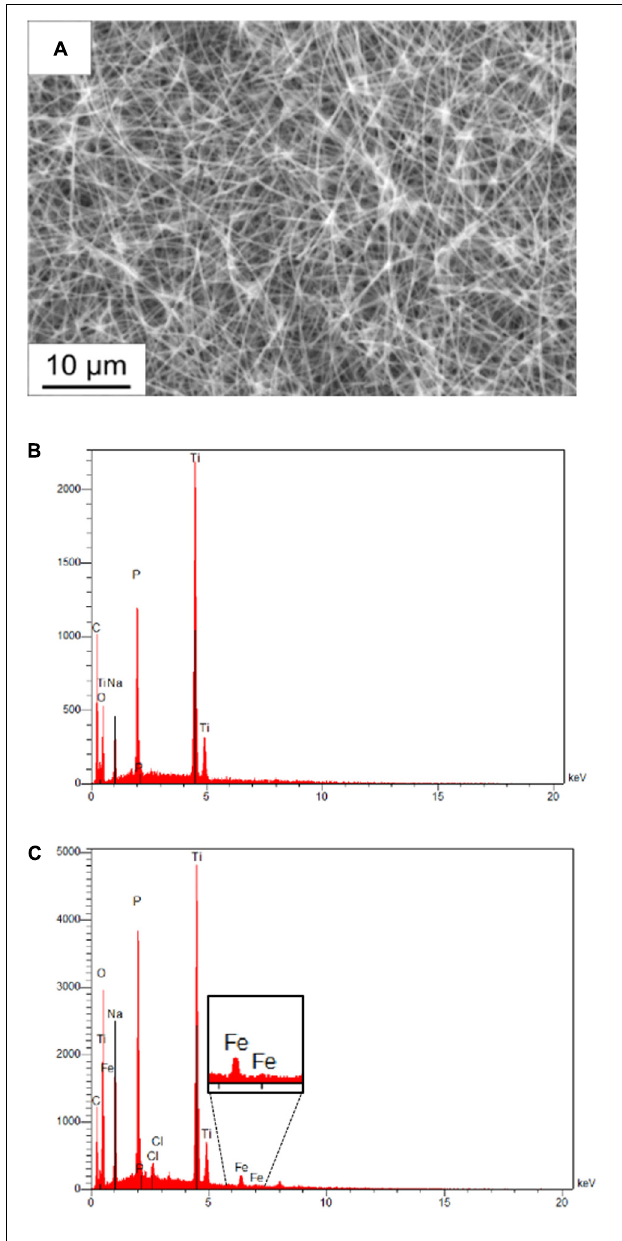
FIGURE 3 | Scanning electron micrograph and energy-dispersive X-ray analysis of PAN fiber electrodes. (A) Scanning electron micrograph of a coated electrospun fiber after adding diluted hydrogenase fraction. The individual fibers of the mat are still visible, which maintains the activity of the whole surface area. (B) Energy dispersive X-ray analysis of a fiber mat without treatment and (C) of a fiber mat treated with pure membrane fraction after electrochemical investigation. The presence of the Fe signal proves the adhesion of hydrogenase-containing membrane fractions on the coated